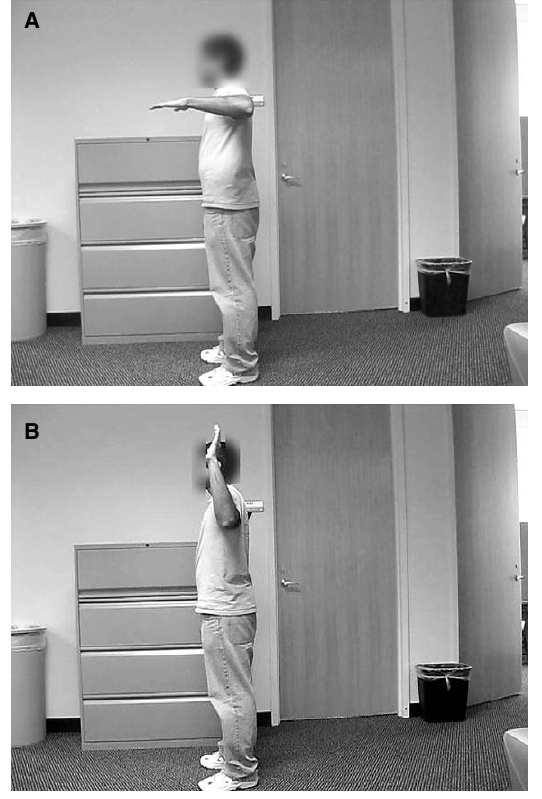
Fig. 10. Lateral and medial movement demonstrated by participant. (a) Subject’s starting position. (b) Subject’s ending